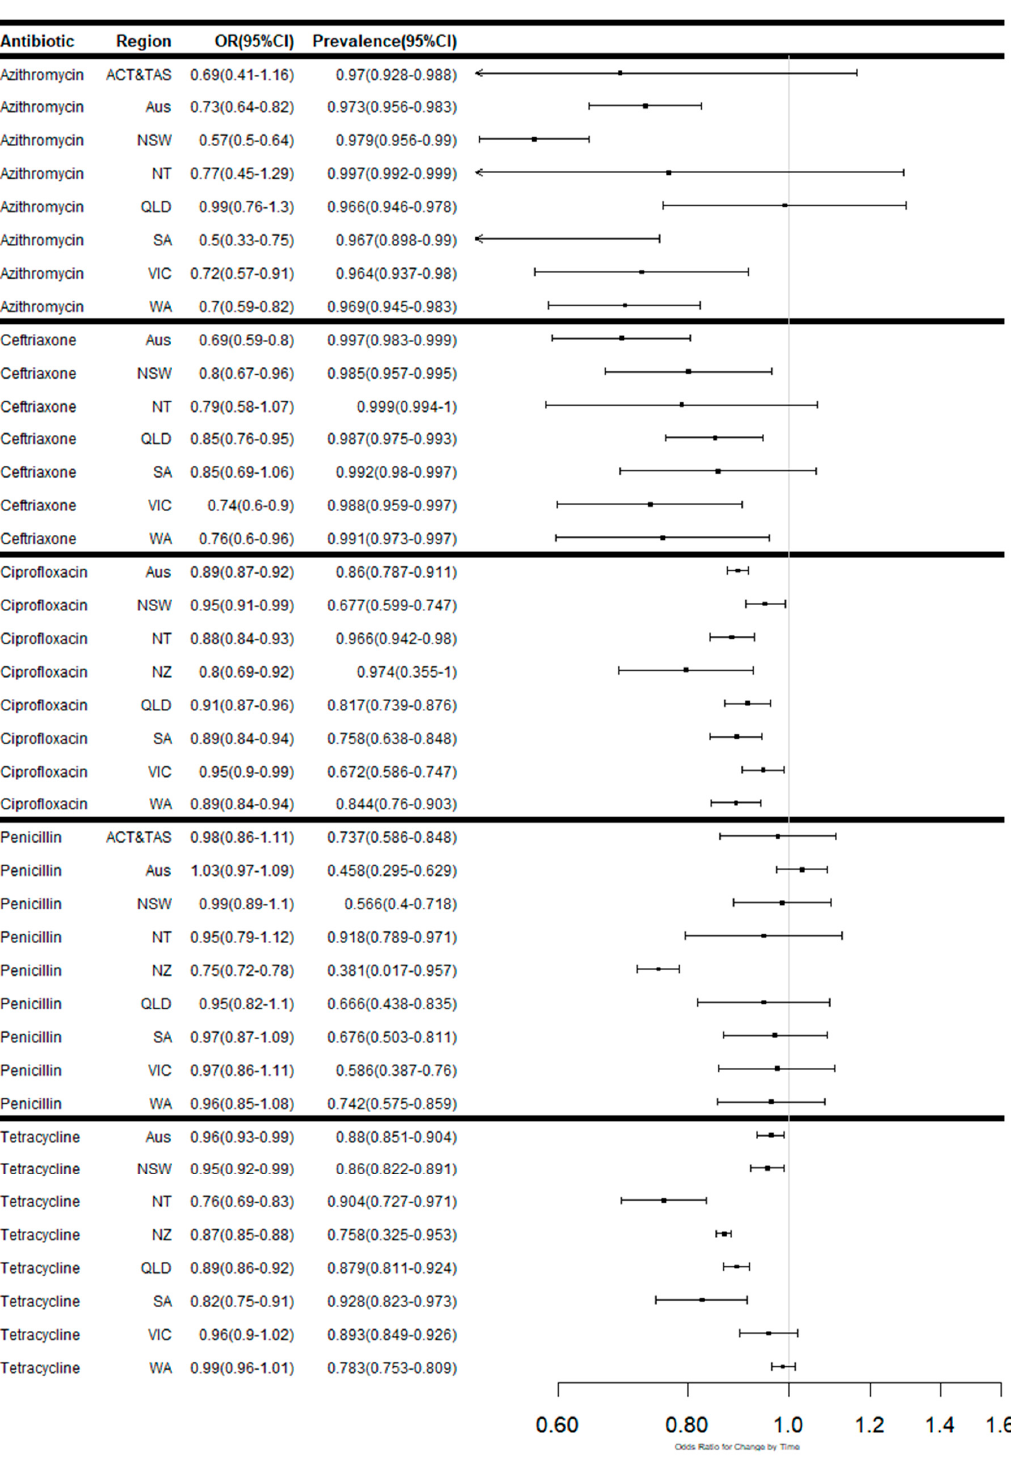
Figure 2. Meta-regression plots showing the odds ratios for changes in proportion and weighted average proportions of isolates susceptible to each antibiotic over time in Australia, Australian states and territories and New Zealand.